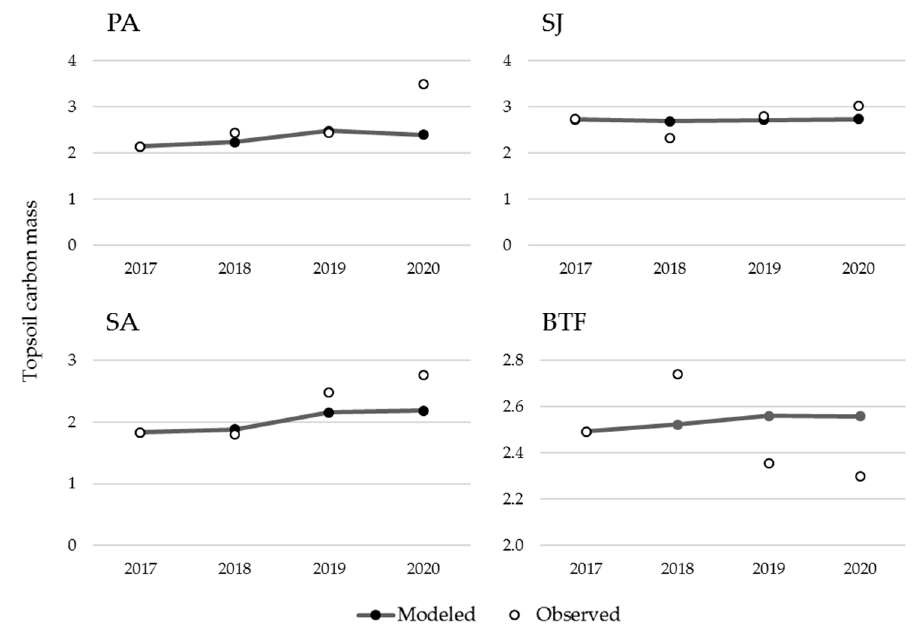
Figure 3. Model simulations (2017–2047) of topsoil carbon mass (in kgC m − 2 yr − 1 ) at 25 cm depth at the four experimental sites– Phragmites australis (PA), Spartina alterniflora (SA), Suaeda japonica (SJ), and Bare Tidal Flat (BTF) in Ganghwa province of Korea. The years (2017, 2018, and 2019) identified within the rectangle confirms the method.